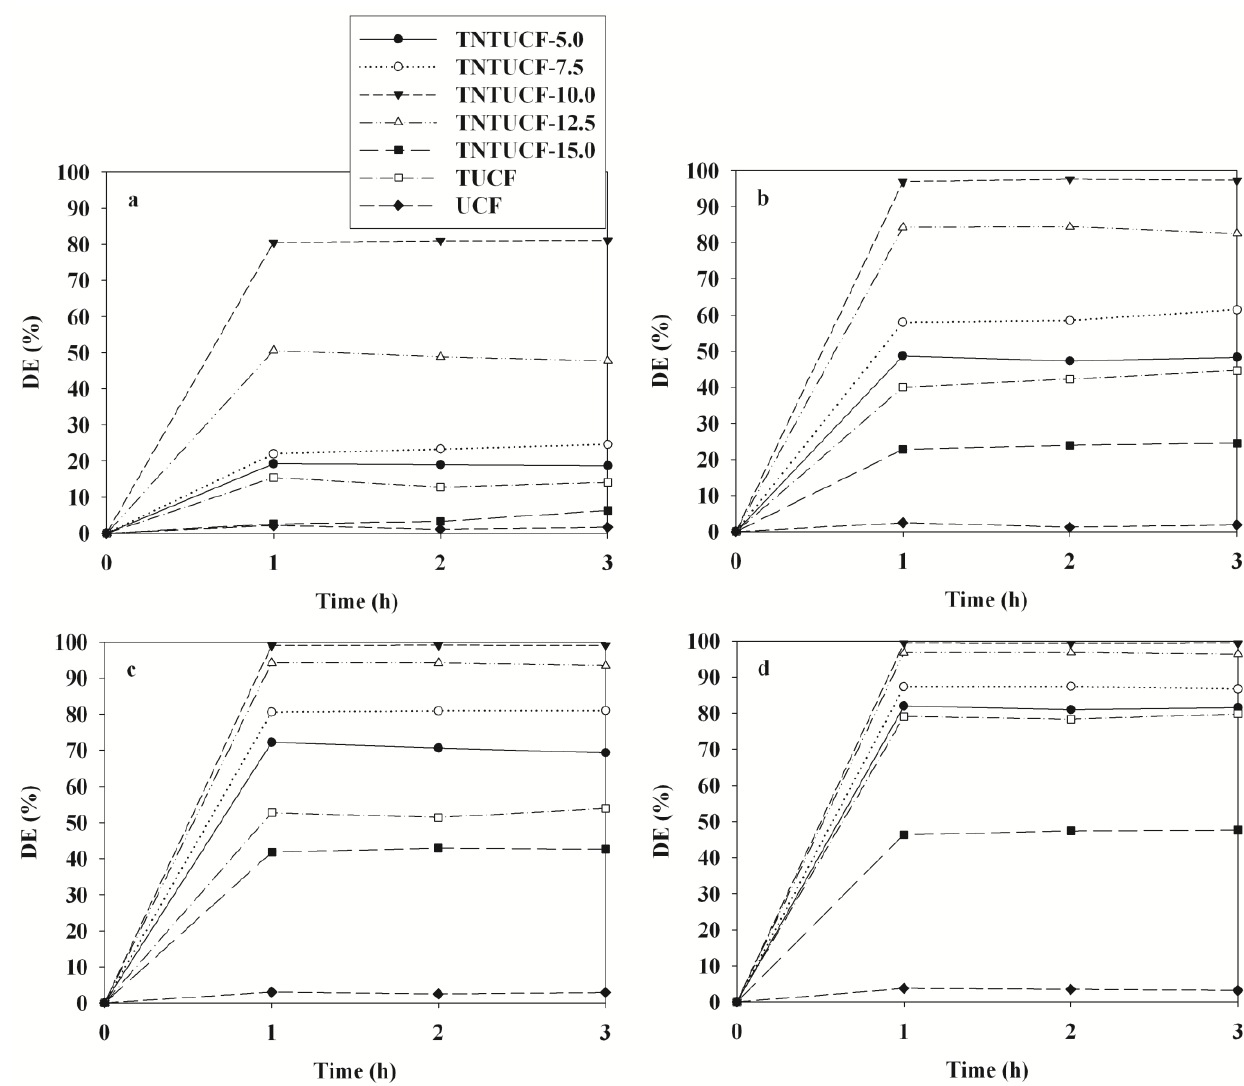
Figure 5. Degradation efficiencies (DE) of ( a ) benzene; ( b ) toluene; ( c ) ethyl benzene; ( d ) o-xylene, as determined using TNTUCFs with different TiO TNTUCF-7.5, TNTUCF-10, TNTUCF-12.5, TNTUCF-15), TUCF, and UCF under UV light